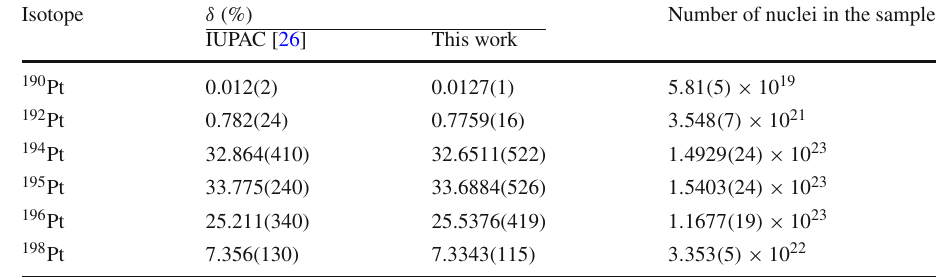
Table 1 Isotopic composition ( δ ) of the platinum sample measured in the present work and the numbers of nuclei of each isotope in the sample calculated by using the measured isotopic concentrations. The combined standard uncertainties of the isotopic abundances are given with a coverage factor k = 2 (approximately 95% level of confidence). The representative isotopic abundances from [26] are given too